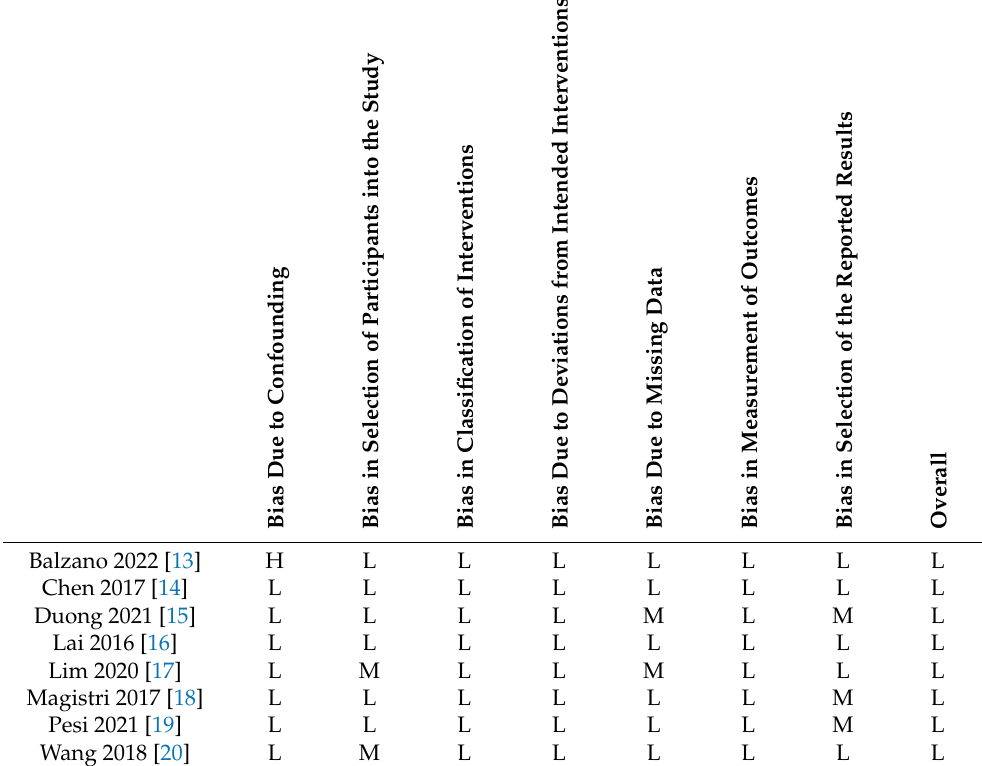
Table 2. ROBINS-I risk of bias assessment for included